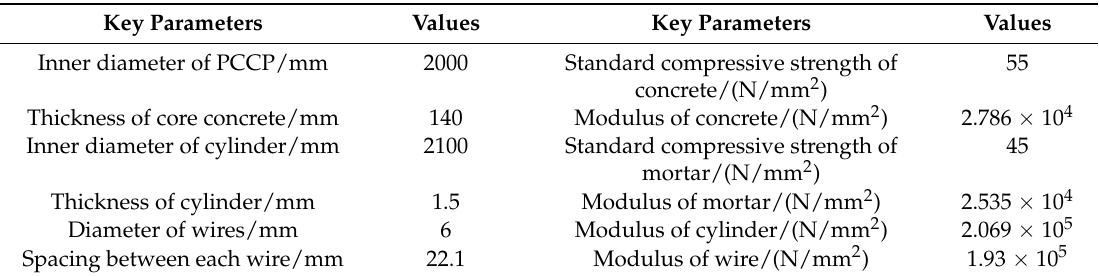
Figure 2. The structural drawing of a PCCPE: 1—Cylinder; 2—Inner concrete core; 3—Outer concrete core; 4—Mortar; 5—Prestressing wires; Dimension: mm. Table 1. Key parameters of the tested PCCP.